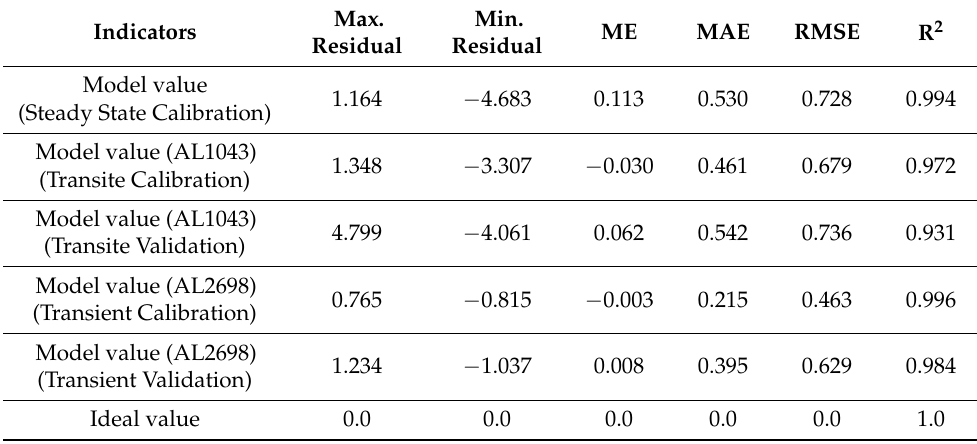
Table 4. Regression indicators between measured and simulated